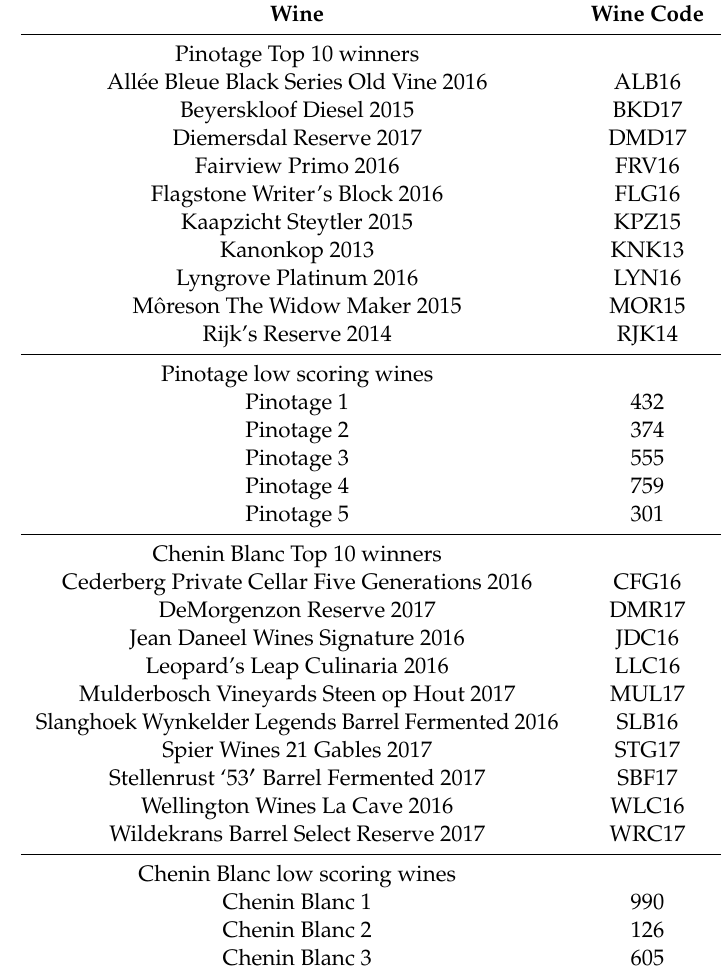
Table 1. Samples and sample codes of the wines included in the current